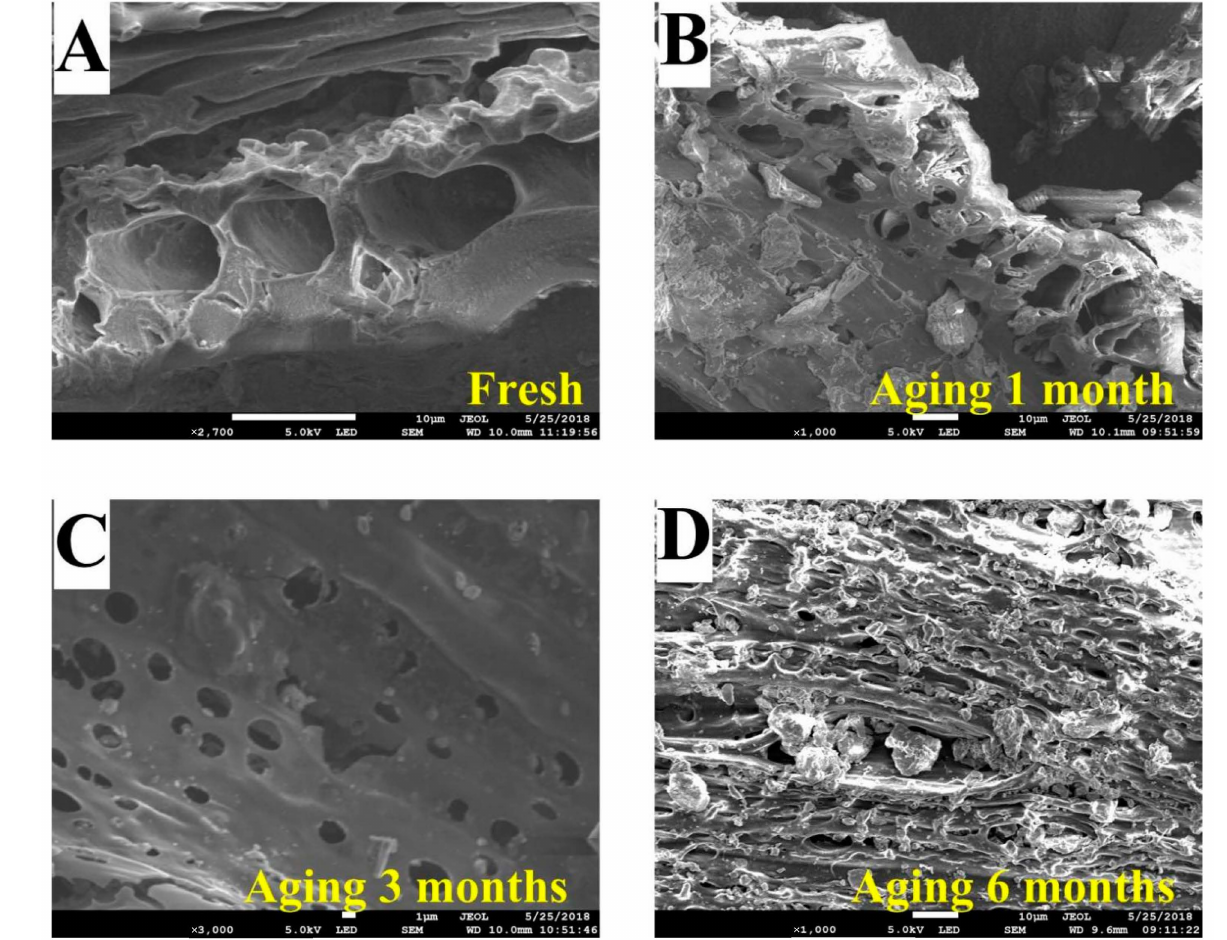
Figure 1. Scanning electronic microscopy (SEM) images of fresh biochar ( A ) and biochar after aging 1 month ( B ), 3 months ( C ), and 6 months ( D ) from